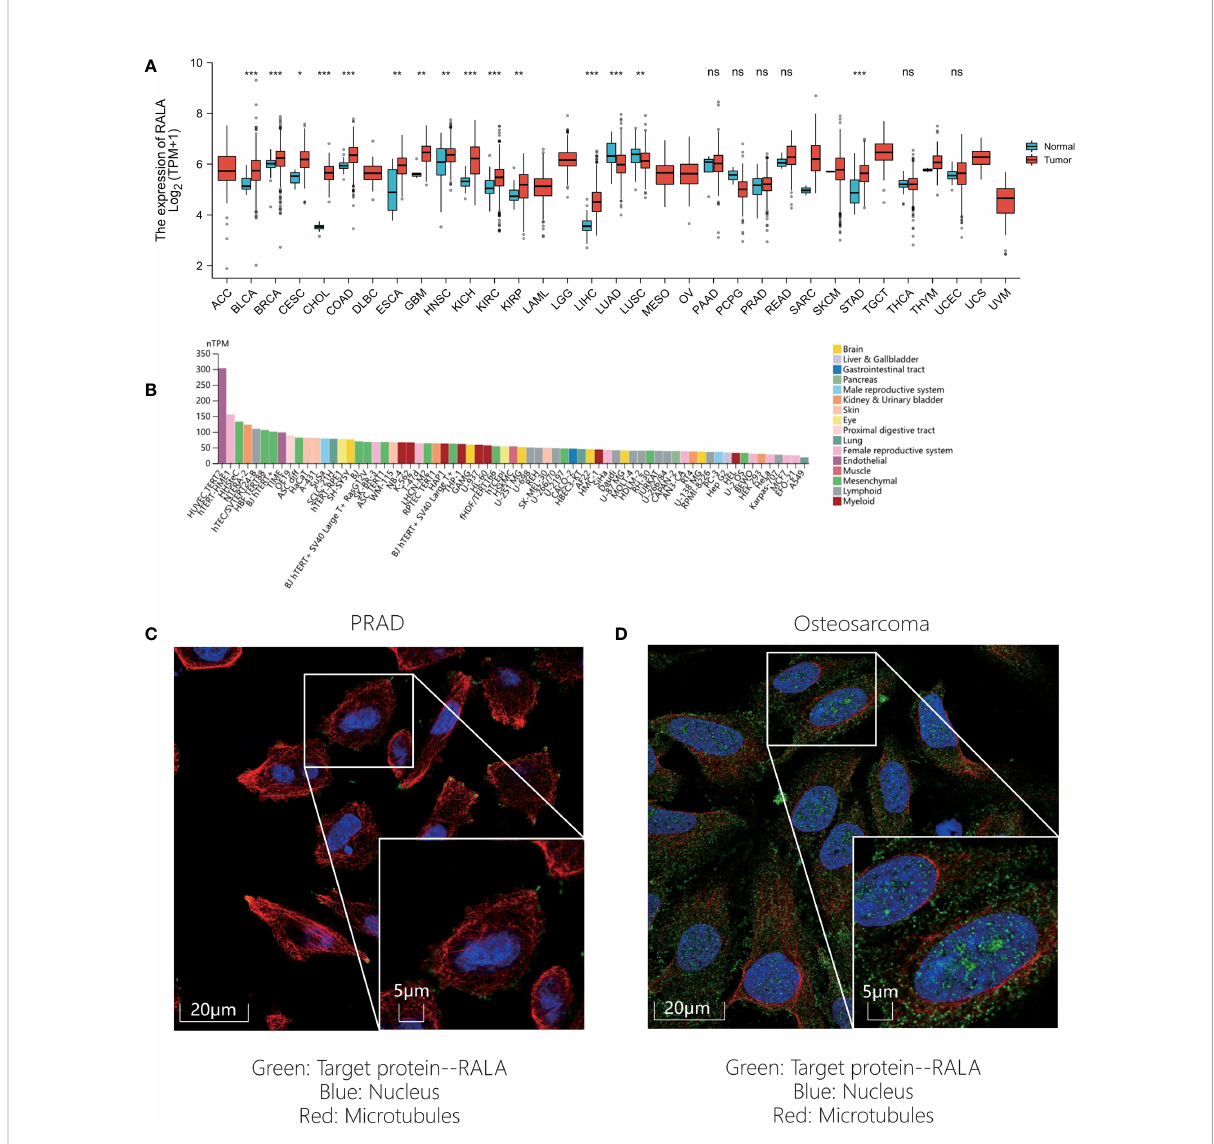
FIGURE 1 RALA expression level of pan-cancer in different databases. (A) RALA expression analyzed by TCGA dataset. (B) RNA expression data as normalized transcript per million (nTPM) values of tissue culture cell lines from HPA. (C-D) IF results for RALA expression levels in cancer. (C) PRAD. (D) Osteosarcoma. ns, no signi fi cance, *p<0.05, **p<0.01,